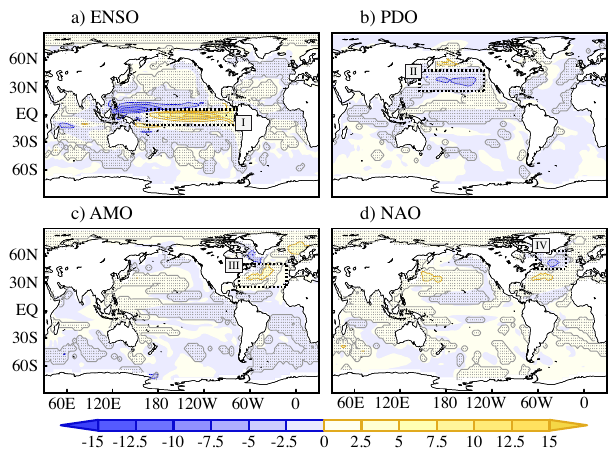
Fig. 13. Regression patterns between the OHC700 anomalies (in 10 8 Jm − 2 ) and the following standardised climate indices in the whole FOR2 simulation: (a) El Ni˜no 3.4; (b) PDO; (c) AMO; (d) NAO. Significance is addressed as in Fig. 6. The black dotted rect- angles delimit the regions assessed in the wavelet coherence analy- sis of Fig. 15. Boxes are defined for each climate index to average the OHC700 anomalies over the regions where their fingerprint is larger.